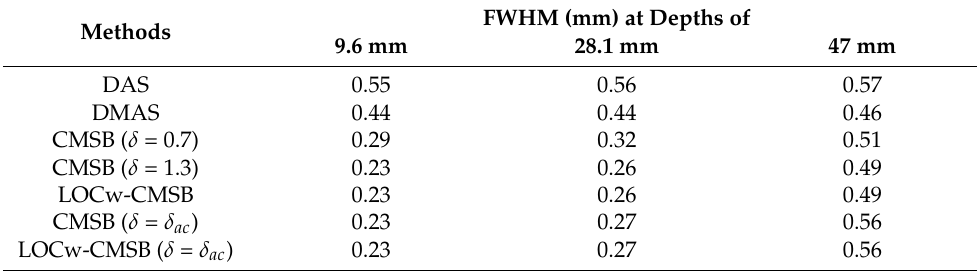
Figure 5. Lateral variations through three points at the depth of ( a ) 9.6 mm, ( b ) 28.1 mm, and ( c ) 47 mm in the experimental point images. Table 3. Lateral FWHM at three different depths in the experimental point